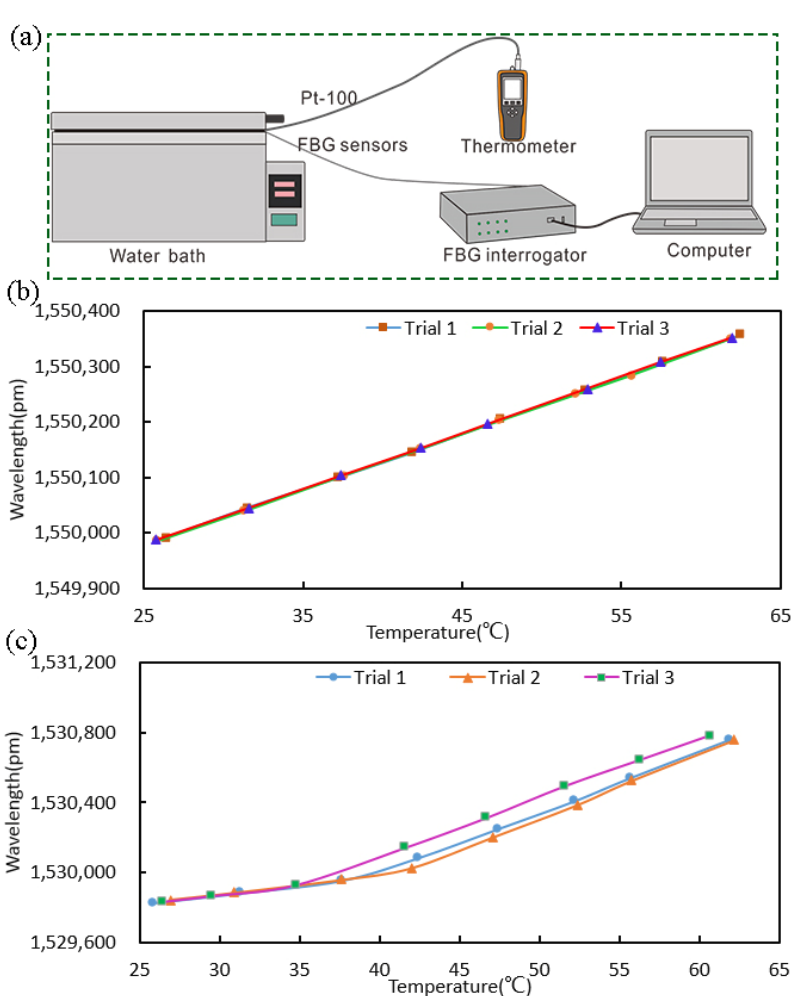
Figure 3. The calibration experiments. ( a ) The calibration experiment setup. ( b , c ) The relationship between wavelength and temperature of the single-ended FBG sensor and dual-ended FBG sensor, respectively.